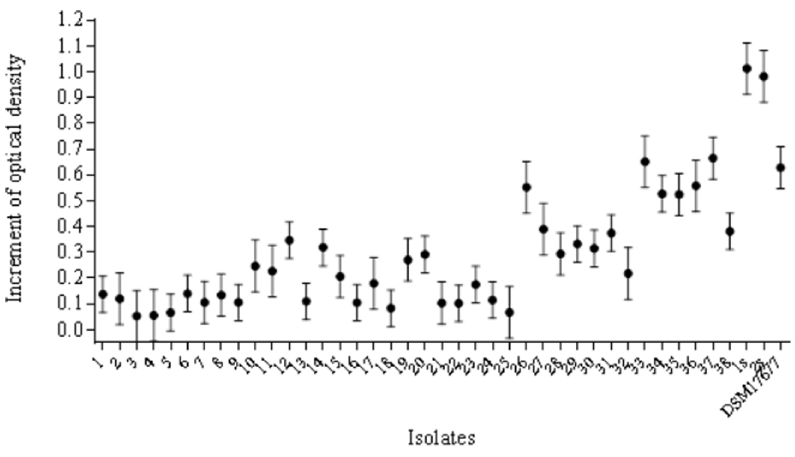
Fig. 1. The growth of each of our 40 isolates and the DSM 17677 isolate, measured spectrophotometrically at hours 5, 17, 29, 41 and 48 using absorbance at the 600 nm wavelength. The average optical density increment was calculated as the difference between 5 h and 48 h of incubation. Error bars indicate the standard error of the